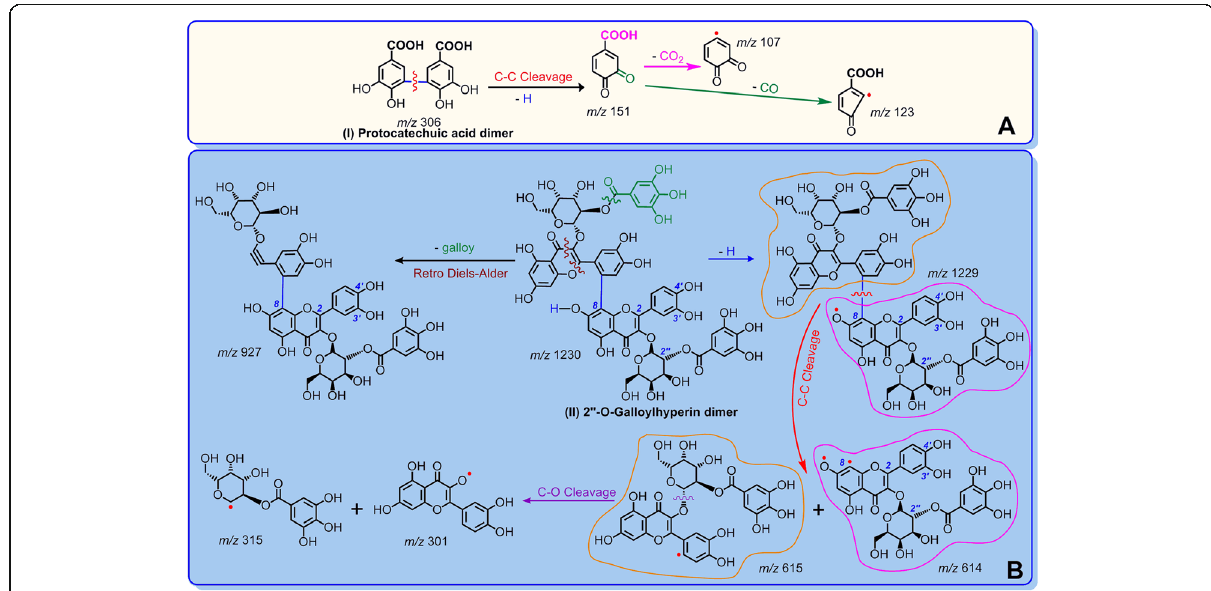
Fig. 7 Proposed RAF products with MS elucidations of protocatechuic acid ( a ) and 2 ″ -O-galloylhyperin ( b ) after mixed with 4-methoxy-TEMPO • . (The MS spectra were in the negative ion model, and the charge imposed by the MS field was not marked. Other linking sites between two phenolic moieties should not be excluded. Other reasonable cleavages should not be excluded in the MS